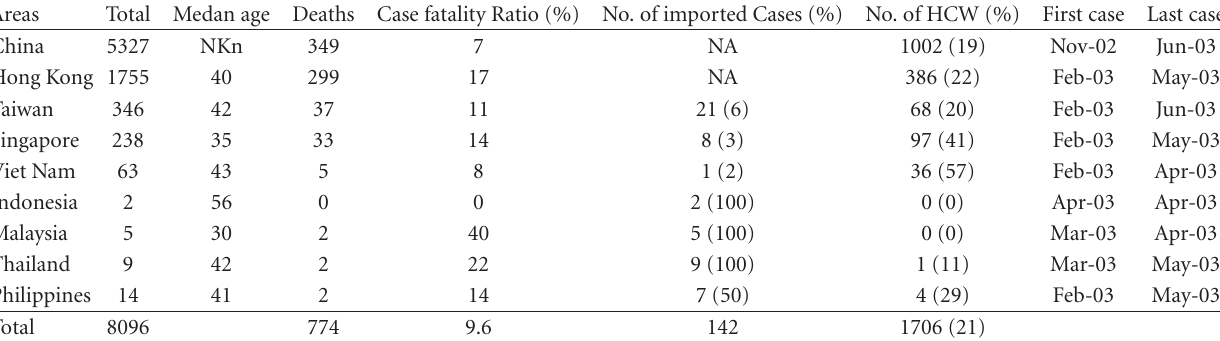
Table 1: WHO SARS report—based on data as of the 31st December 2003.